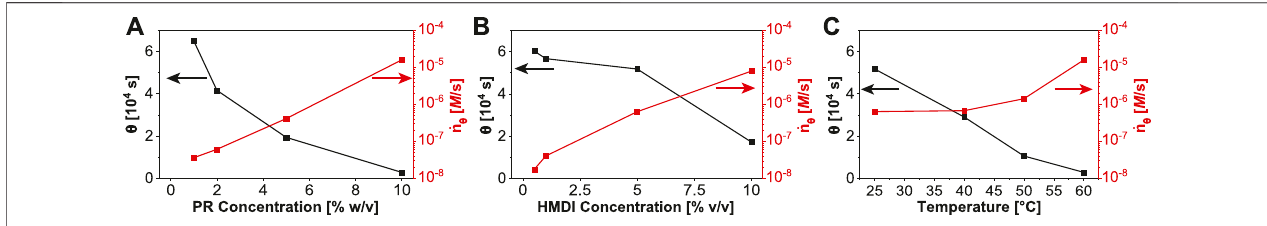
FIGURE 2 | Tracking gelation as a function of reaction conditions. Gelation halftime ( θ ) and rate of production of elastically effective crosslinks ( _ n θ ) against (A) polyrotaxane concentration (60 ° C, 5% HMDI) (B) cross-linker concentration (25 ° C, 10% PR) and (C) temperature (5% HMDI, 10% PR).